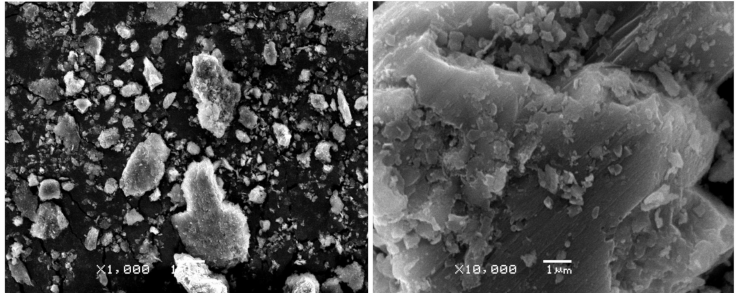
Figure 11. SEM image of Henan lithium-bearing diaspore.